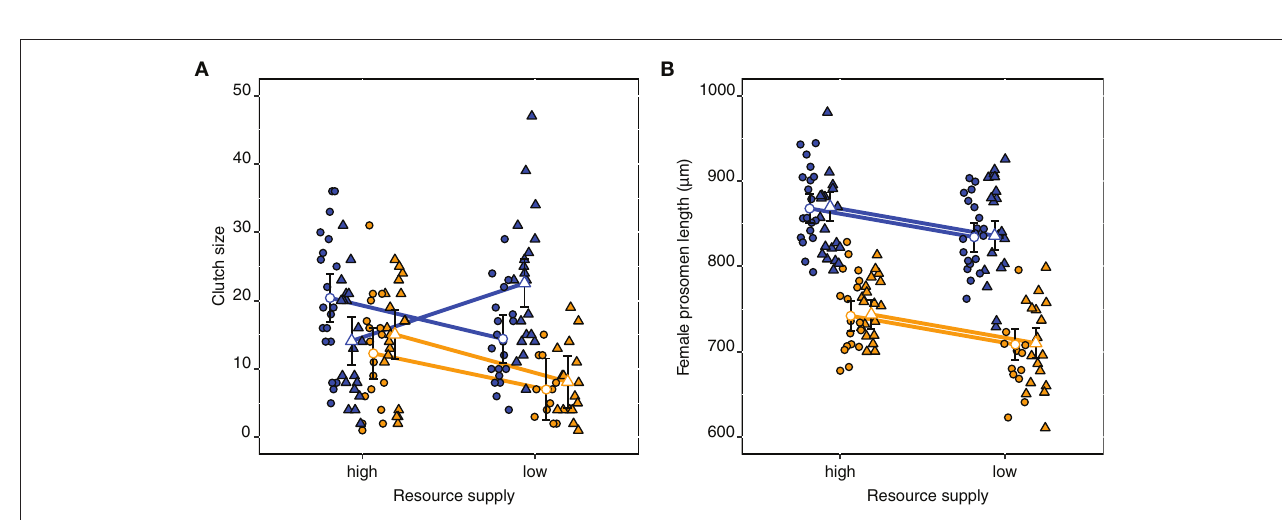
FIGURE 6 | Nauplii (A) and copepodites + adults (B) counts for the STHLM (orange) and GOR (blue) E. affinis populations at the end of the experiment. Triangles and circles are respective pelagic and benthic treatments, the resource supply treatment is shown on the x-axis. Estimates and 95% CI are from generalized least square models fitted with a power covariate to control for unequal variances. Observations are included as points. In (B) average number of individuals at start are shown with 95% CI for the STHLM and GOR populations, denoted by the letters S and G.